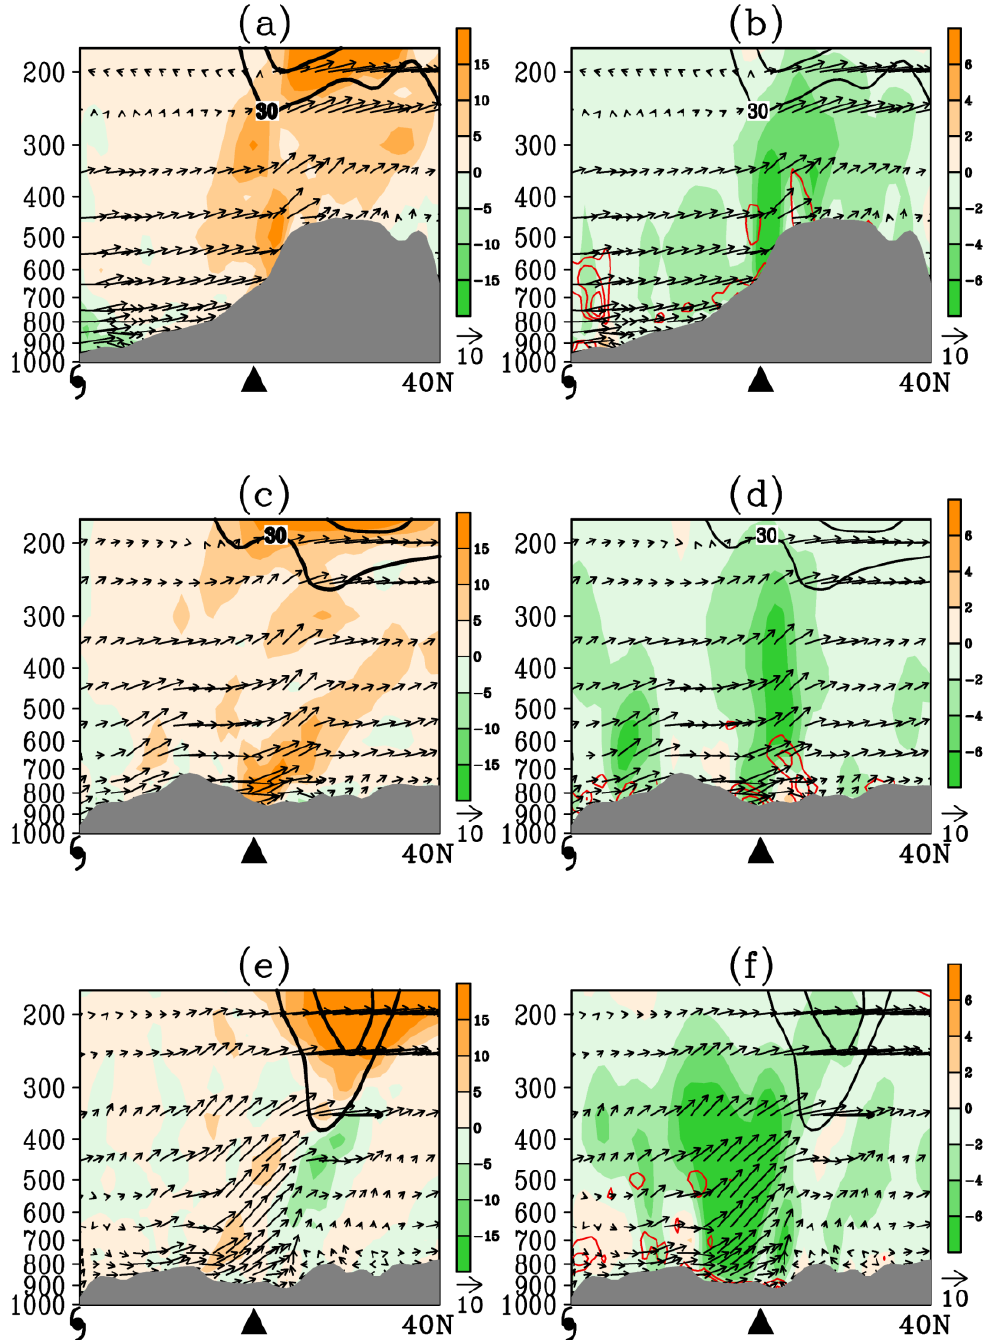
Figure 11. The same as Figure 9, but for horizontal temperature advection (shaded, units: 10 − 5 K s − 1 ), wind flow anomaly (vector, the horizontal flow in m s − 1 , and the vertical flow is in 10 − 2 pa s − 1 ) and zonal wind speed (every 5 m s − 1 from 35 m s − 1 , black lines) on ( a ) 11 May 2002, ( c ) 12 May 2002 and ( e ) 13 May 2002. And frontogenesis (red lines, every 1 × 10 − 9 K m − 1 s − 1 from 1 × 10 − 9 K m − 1 s − 1 ), vertical pressure velocity (shaded, units: 10 − 2 pa s − 1 ), wind flow anomaly (vector, the horizontal flow in m s − 1 , and the vertical flow is in 10 − 2 pa s − 1 ) and zonal wind speed (every 5 m s − 1 from 35 m s − 1 , black lines) on ( b ) 11 May 2002, ( d ) 12 May 2002 and ( f ) 13 May 2002.